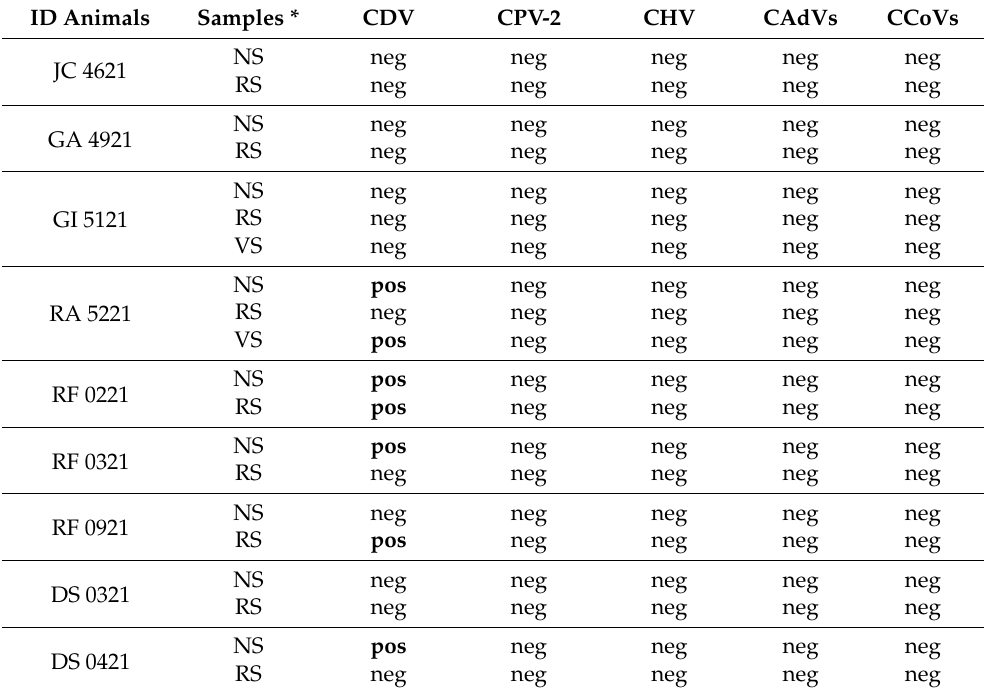
Table 2. Results of molecular investigations carried out on samples collected from animals under study. ID